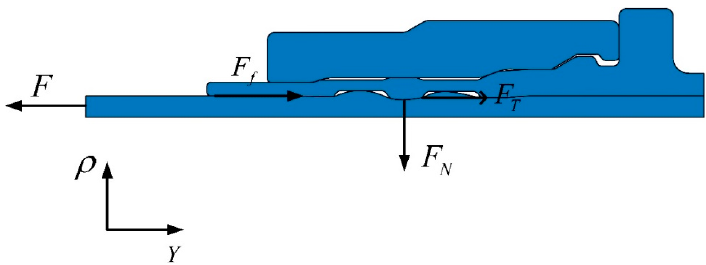
Figure 11. Force analysis on titanium tube during the pull-off process.